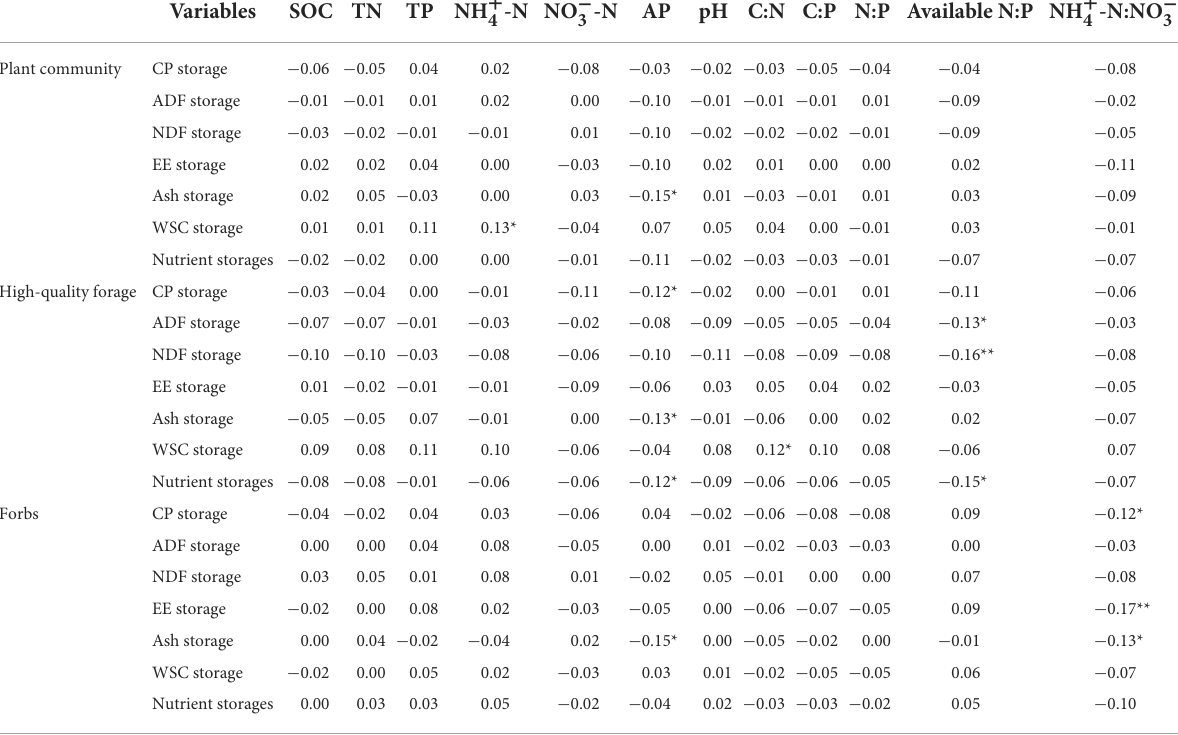
TABLE 2 Correlation analysis between forage nutrient storages of plant community, high-quality forage or forbs, and soil variables.